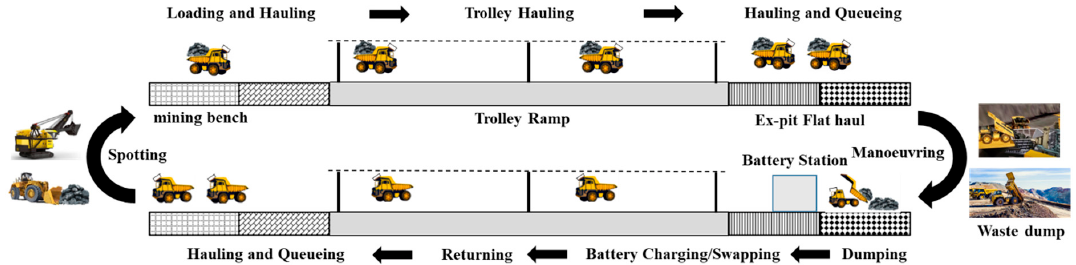
Figure 17. A schematic of dual trolley BT systems operational process.